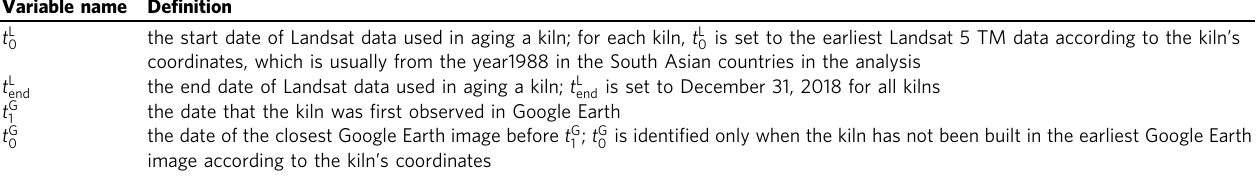
Table 1 Notations used in the spatiotemporal estimation of the date each of the brick kilns were constructed.